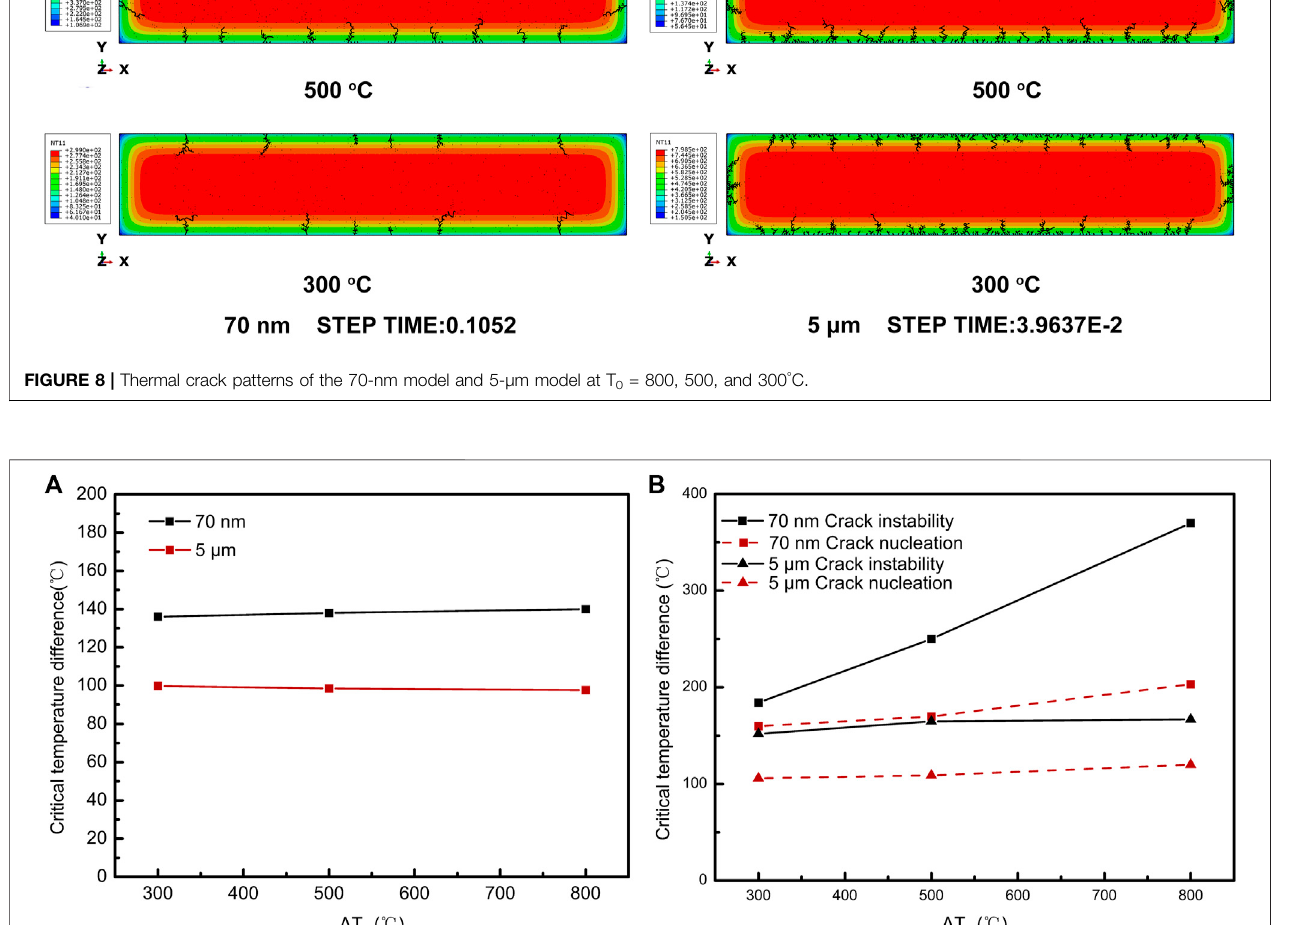
Frontiers in Materials |